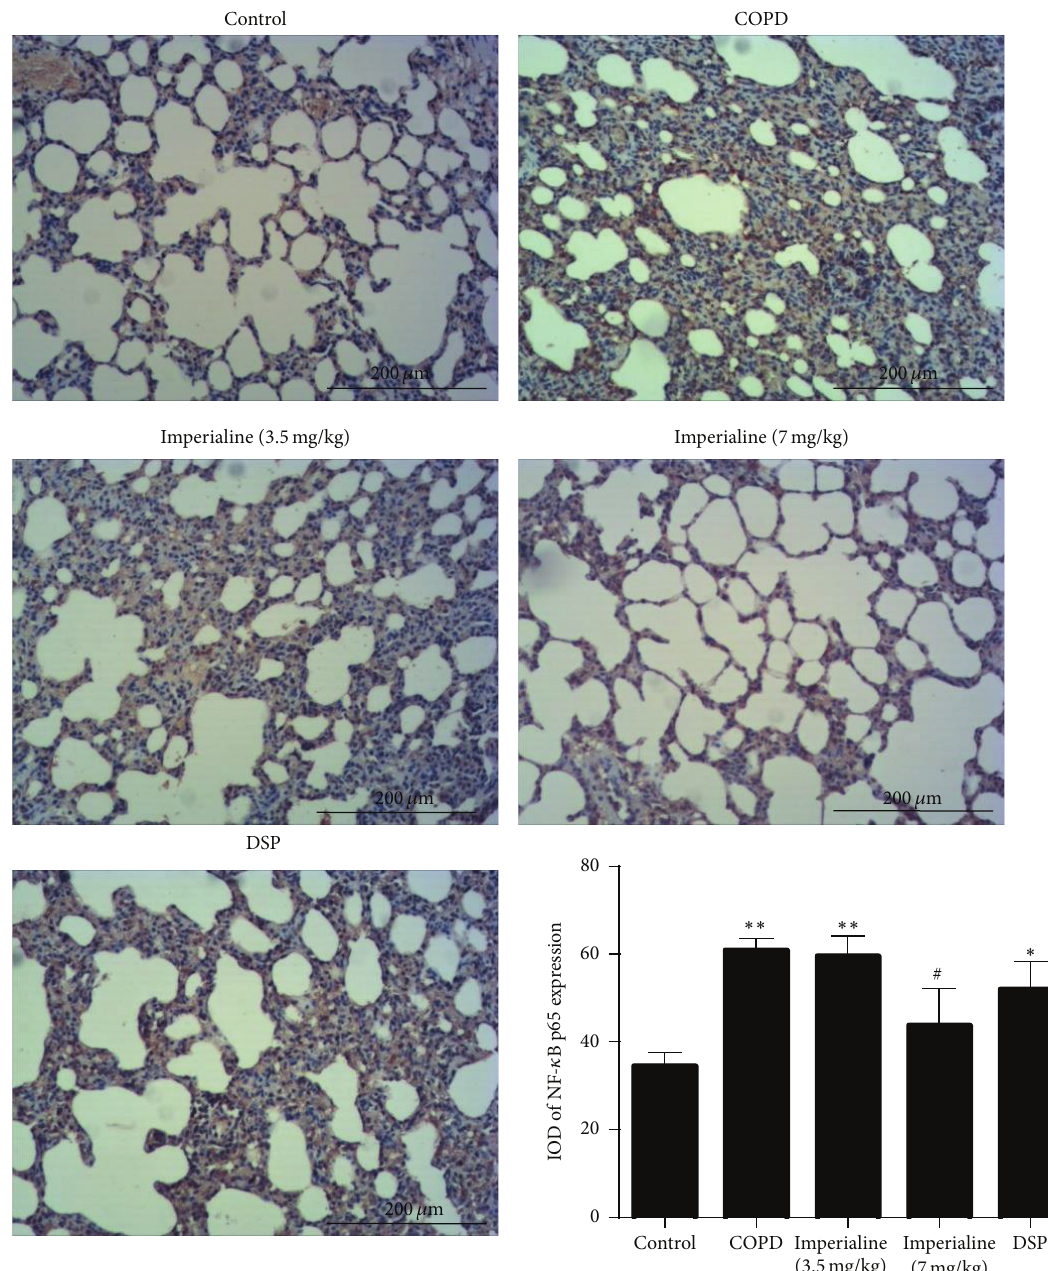
Figure 9: Immunohistochemical staining of NF- 𝜅 B in lung tissues of rats in different groups and IOD of NF- 𝜅 B expression. Results were expressed as the mean ± SEM ( 𝑛 = 10 ). Significant differences compared with the control group were designated as ∗ 𝑃 < 0.05 and ∗∗ 𝑃 < 0.01 . Significant differences compared with the COPD group were designated as # 𝑃 < 0.05